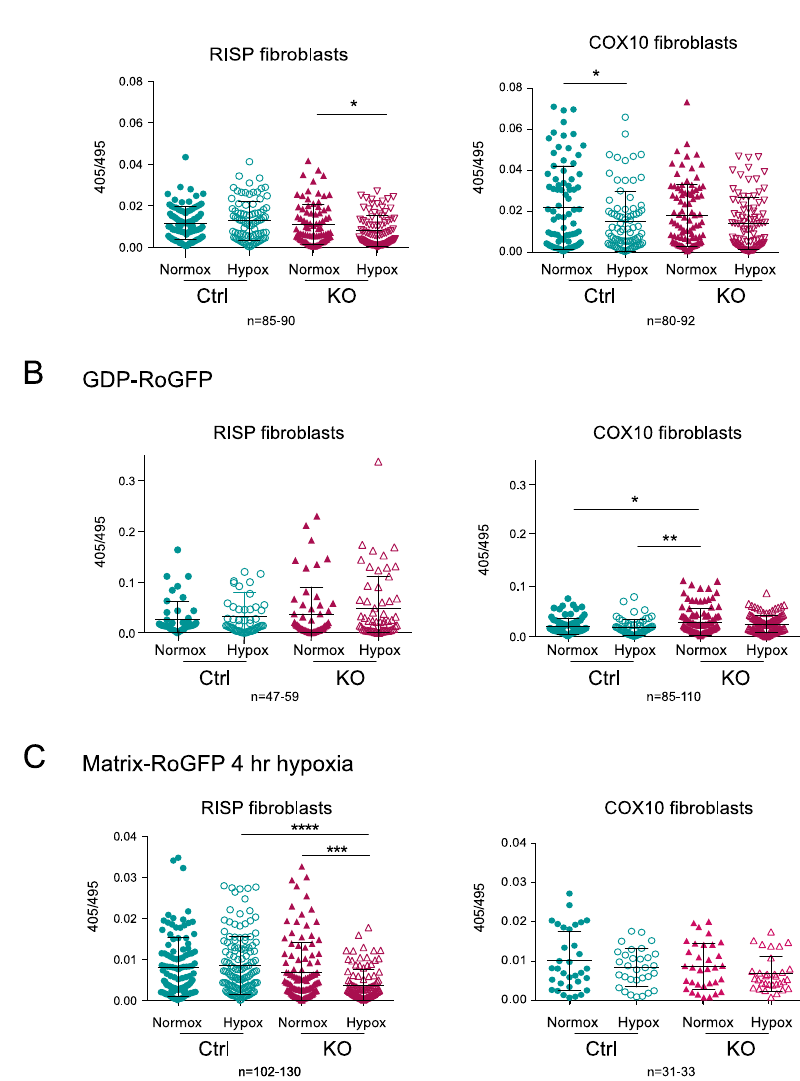
Figure 8. Determination of mitochondrial ROS production using the redox sensitive biosensor RoGFP in RISP and COX10 KO fibroblasts. ( A ) Controls, RISP and COX10 KO fibroblasts were transfected with plasmids expressing Matrix-RoGFP (targeted to the mitochondrial matrix) and 24 h after transfection cells were placed either under normoxia (21% oxygen) or hypoxia (1% oxygen) for 24 h. Cells were fixed with 4% PFA and imaged in a confocal microscope at two excitation wavelengths, 405 and 495 and emission of 510 nm. Fluorescence ratio 405/495 was calculated using ImageJ software for each cell. ( B ) Controls, RISP and COX10 KO cells were transfected with GDP-RoGFP (targeted to the mitochondrial intermembrane space) and exposed to normoxia and hypoxia as described in (A). ( C ) Controls, RISP and COX10 KO fibroblasts were transfected with matrix-RoGFP and 24 h post-transfection exposed to either normoxia or 1% oxygen for 4 h and immediately fixed with 4% PFA and imaged as described in (A). Graphs represent the combined results of the fluorescence of individual cells for at least 3–4 independent experiments. In each experiment, 20 to 30 cells were analyzed. Each symbol represents one cell and the number of cells (n) is indicated below each graph. Statistical analysis was performed using one-way ANOVA followed by Tukey’s multiple comparisons test. Statistical significance is represented by * p < 0.05, ** p < 0.01, *** p < 0.001 and **** p < 0.0001. Exposure to hypoxia did not increase ROS production in any of the cell lines.